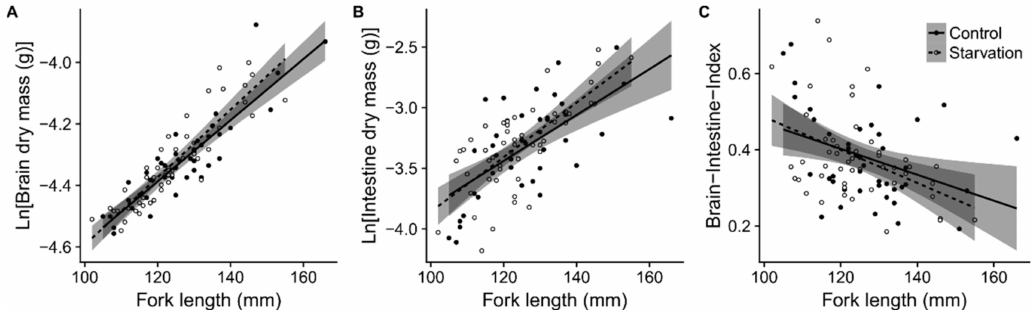
Figure 2. Predicted effects of previous feeding treatment (and subsequent compensatory growth in the “Restricted” group) on ( A ) brain dry mass, ( B ) intestine dry mass, and ( C ) brain-intestine-index. None of the treatment effects were statistically significant. Linear regression lines are based on raw data and are shown along with 95% confidence bands which are shaded in